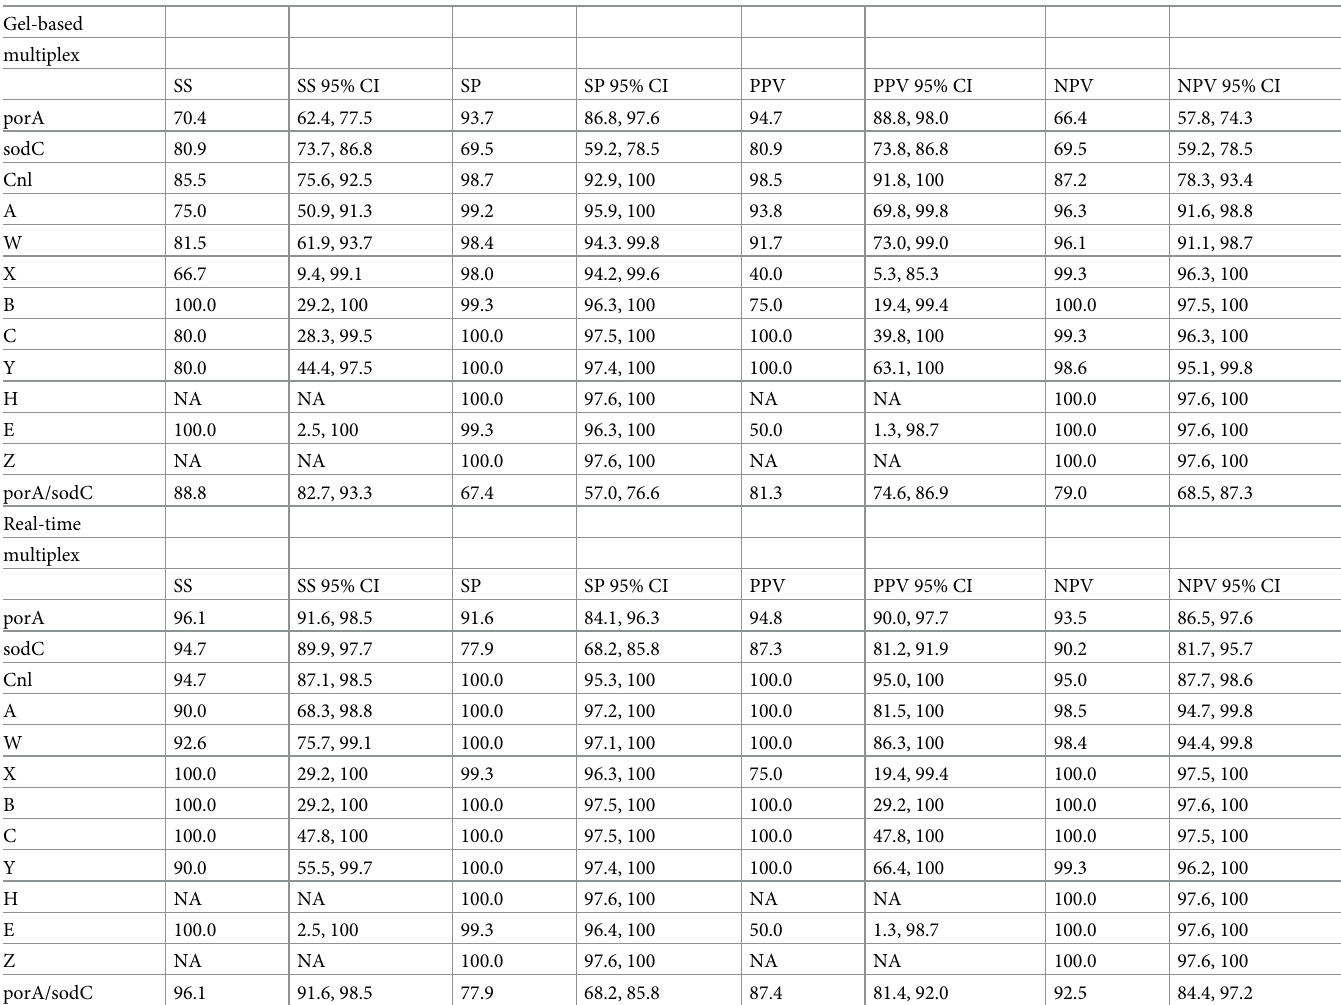
Table 4. Statistical analysis results for the multiplex gel-based and qPCR